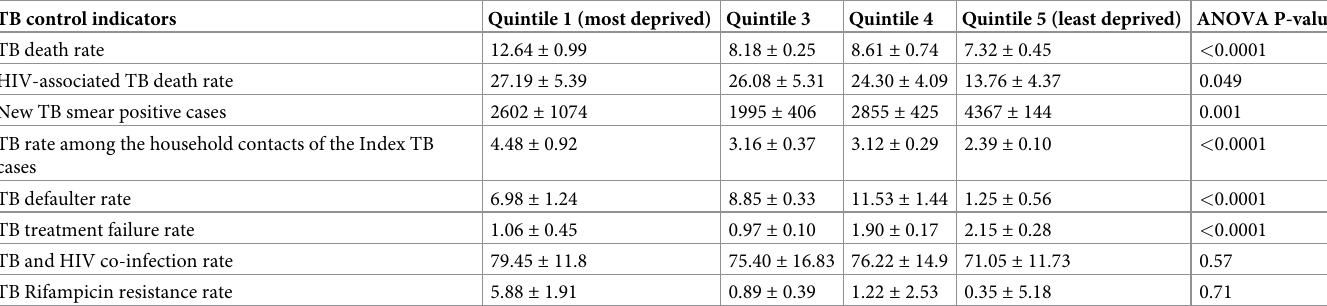
Table 4. A 5-year average (mean ± SD) notification of TB indicators by levels of socio-economic deprivation from 2009 to 2013. TB control